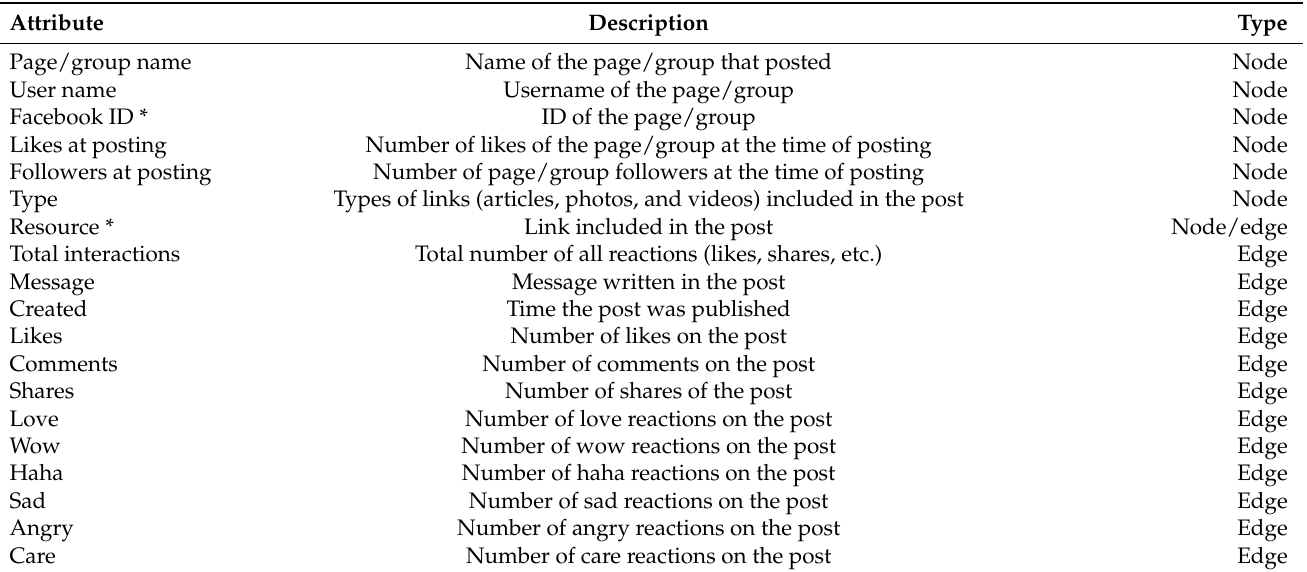
Table 2. Facebook’s attributes for building the Facebook graph and features. All fields marked with an asterisk (*) are required.